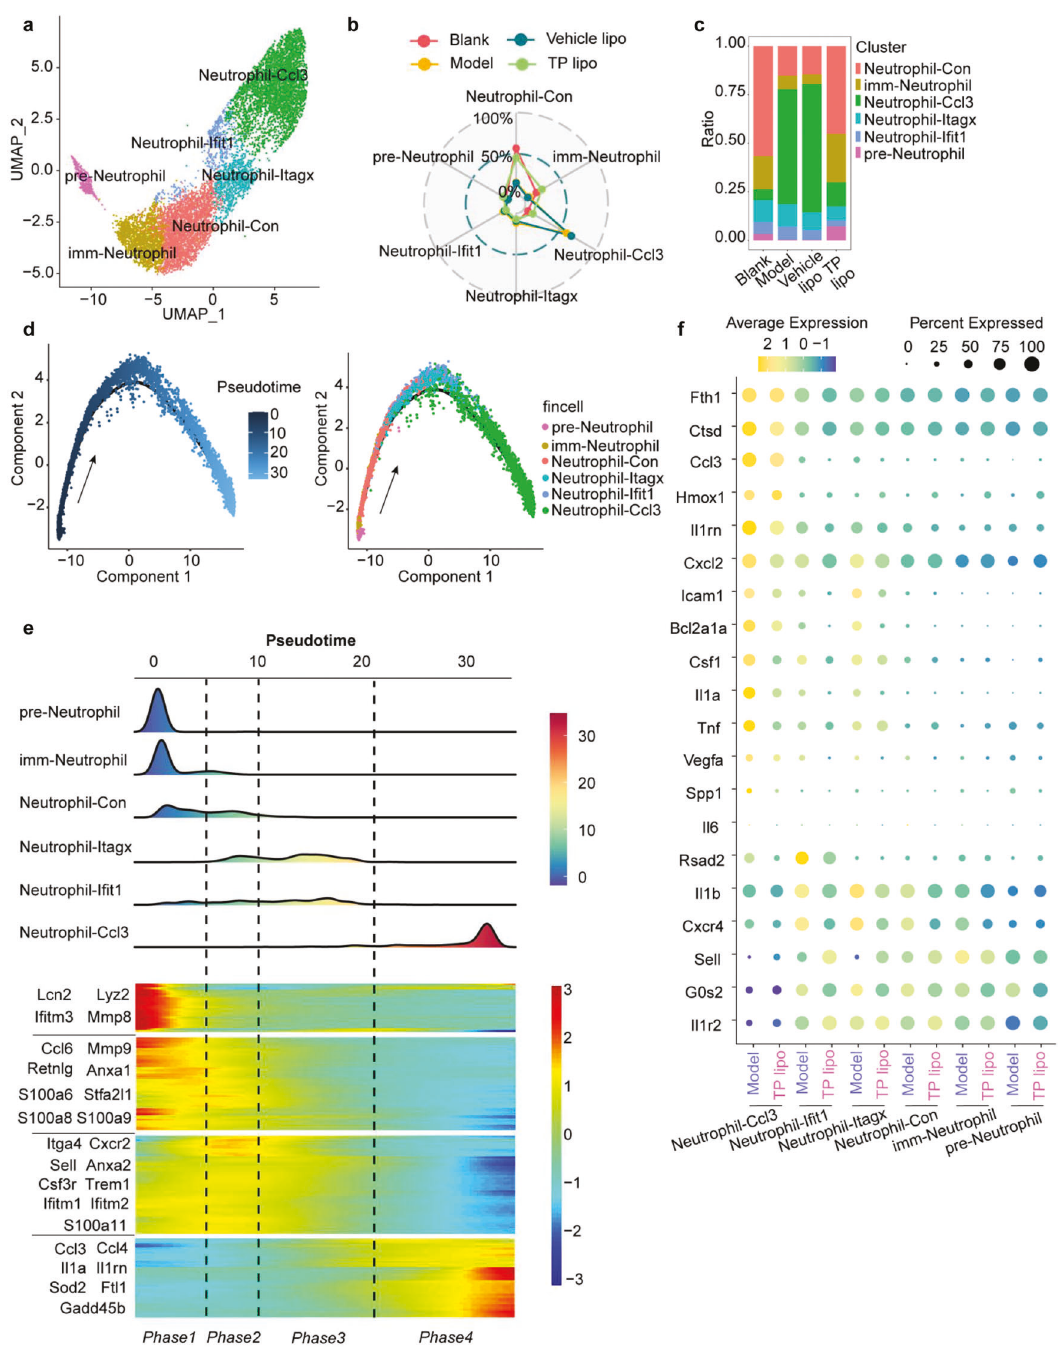
Fig. 6 Neutrophil-Ccl3 is the main in fl ammatory neutrophil in the mouse lung of the FA-S-induced ARDS model. a UMAP plot of six subsets of neutrophils colored by cluster identity. b Radar chart indicating the relative expression of each neutrophil cell population. c Ratio of all cells belonging to the neutrophil clusters. d Pseudotime trajectory analysis of the neutrophil clusters. e Heatmap of the gene expression dynamics during neutrophil differentiation, following the trajectory timeline shown in ( d ). Left, representative enriched genes; right, the gene group. f Dot plot showing the scale expression of selected signature genes for two groups based on six subsets of neutrophils. Yellow, high expression; Green, low expression; Size, the proportion of neutrophil subpopulations expressing transcription